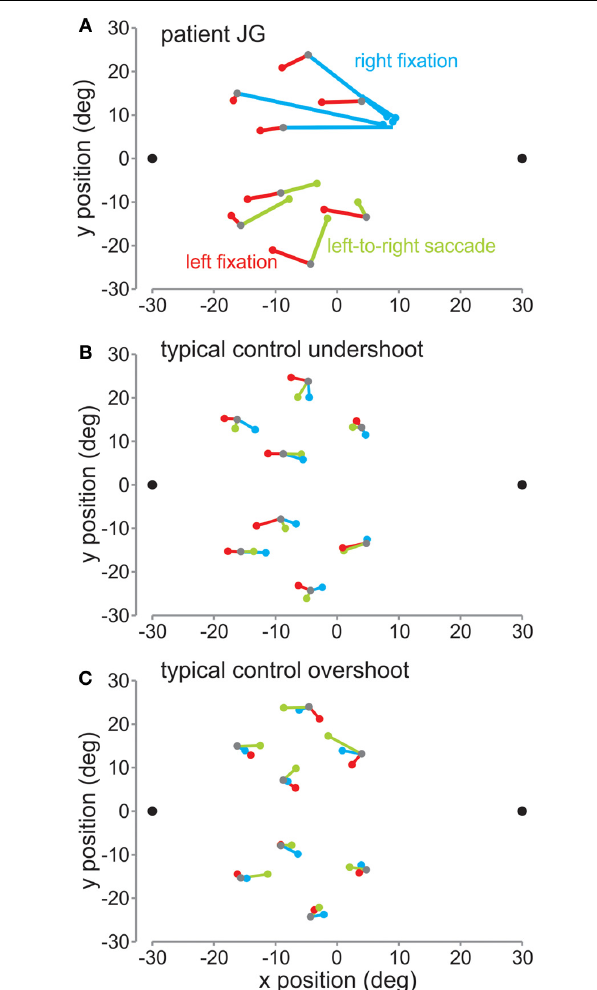
FIGURE 3 | Mean reach endpoints. (A) Mean reach endpoints (in deg relative to screen center) for the patient’s reaches for the left fixation (red), right fixation (blue), and saccade left-to-right (green) sessions. The 8 target locations are depicted by gray dots. The colored dots represent the mean endpoints for each of the conditions. They are joined by corresponding lines to their respective targets. (B) Mean reach endpoints for a typical control showing an undershoot pattern. (C) Mean reach endpoints for a typical control showing an overshoot pattern.